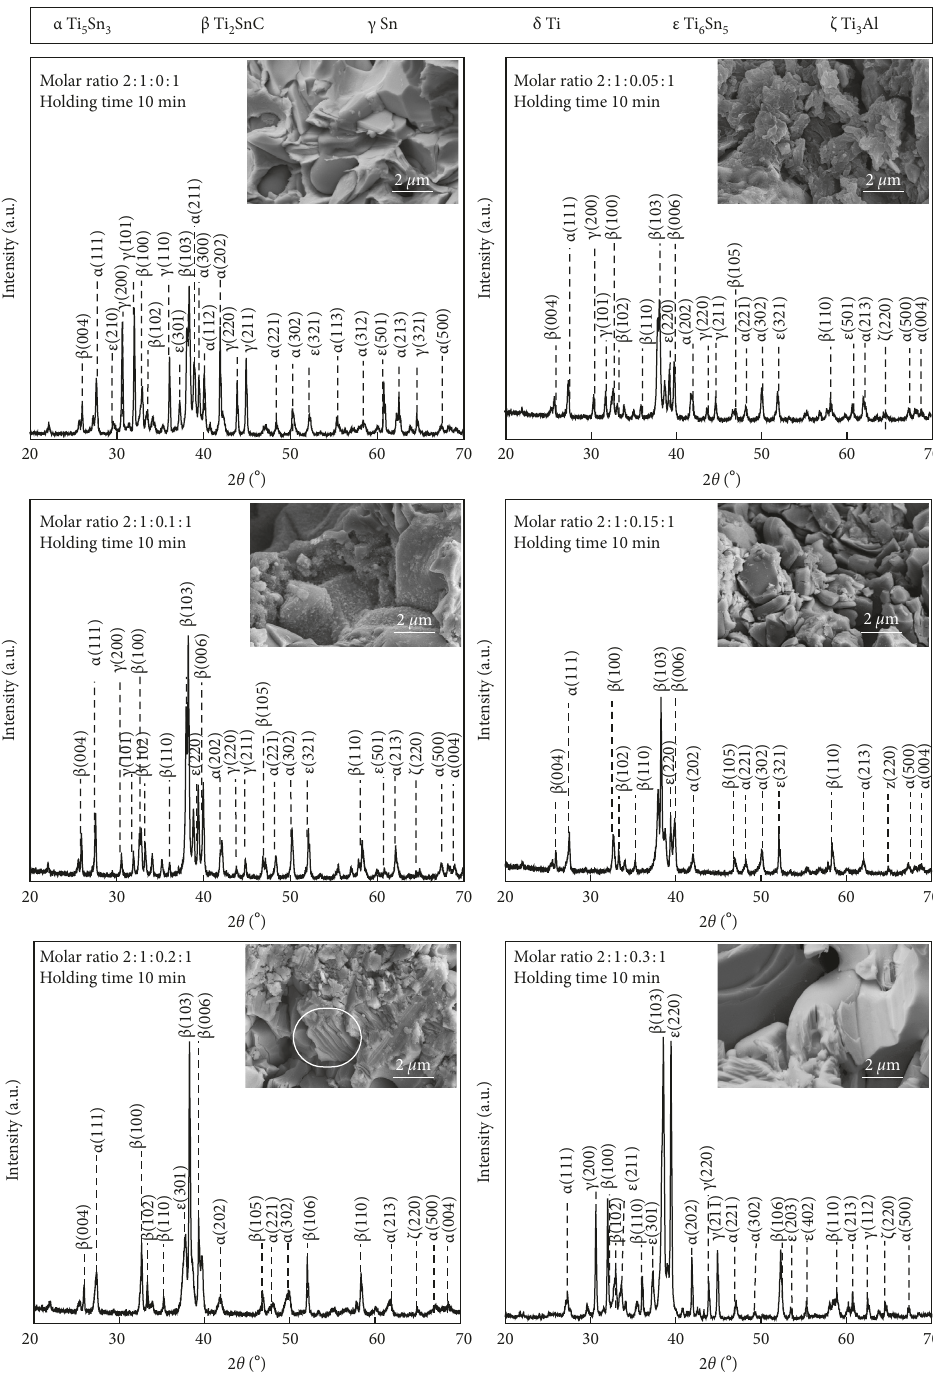
Figure 2: Sintering powders Ti 2 SnC at different molar ratios Ti : Sn: Al :C (cid:31) (a) 2 :1: 0:1; (b) 2:1 :0.05:1; (c) 2:1 :0.1:1; (d) 2:1:0.15:1; (e) 2:1:0.2 :1; (f) 2 :1: 0.3:1 at 1325 °